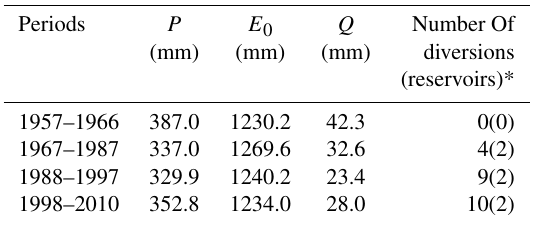
Table 2. Mean annual fluxes in the Hailiutu River catchment (C1) in different